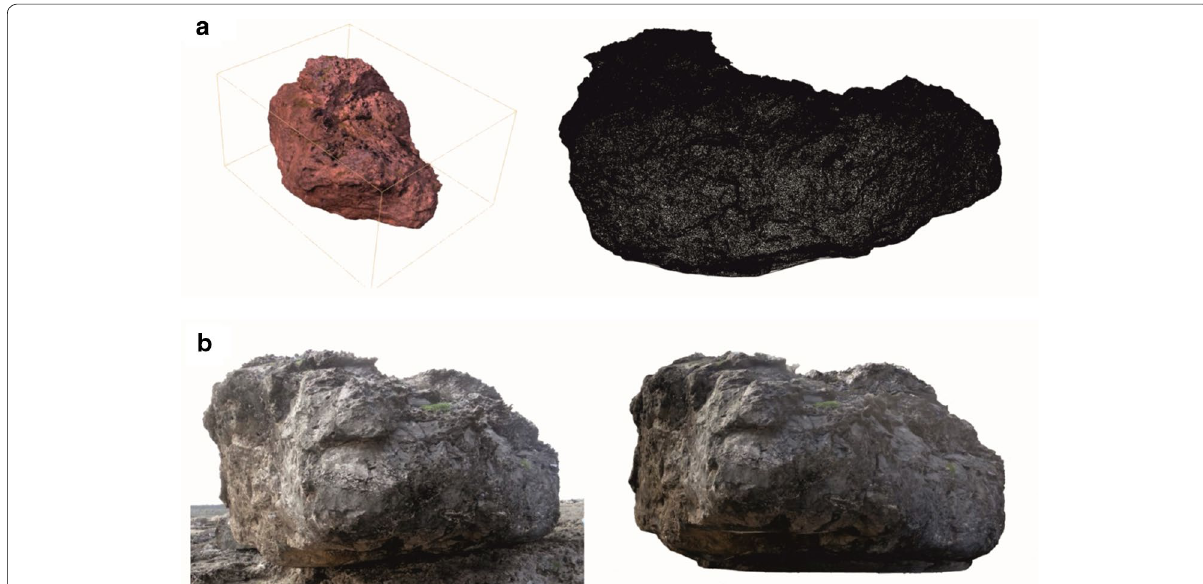
Fig. 7 Analyses on boulders. a Perspective view and mesh model of a boulder deposited on the Island of Bonaire, Lesser Antilles, Caribbean Sea; b comparison between the original photograph and the numerical model